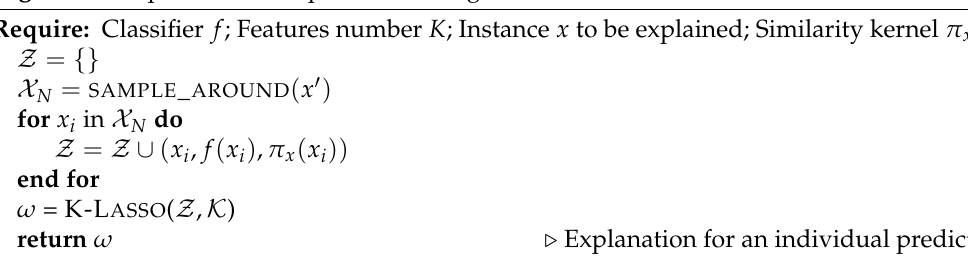
Algorithm 2 Sparse linear explanation using